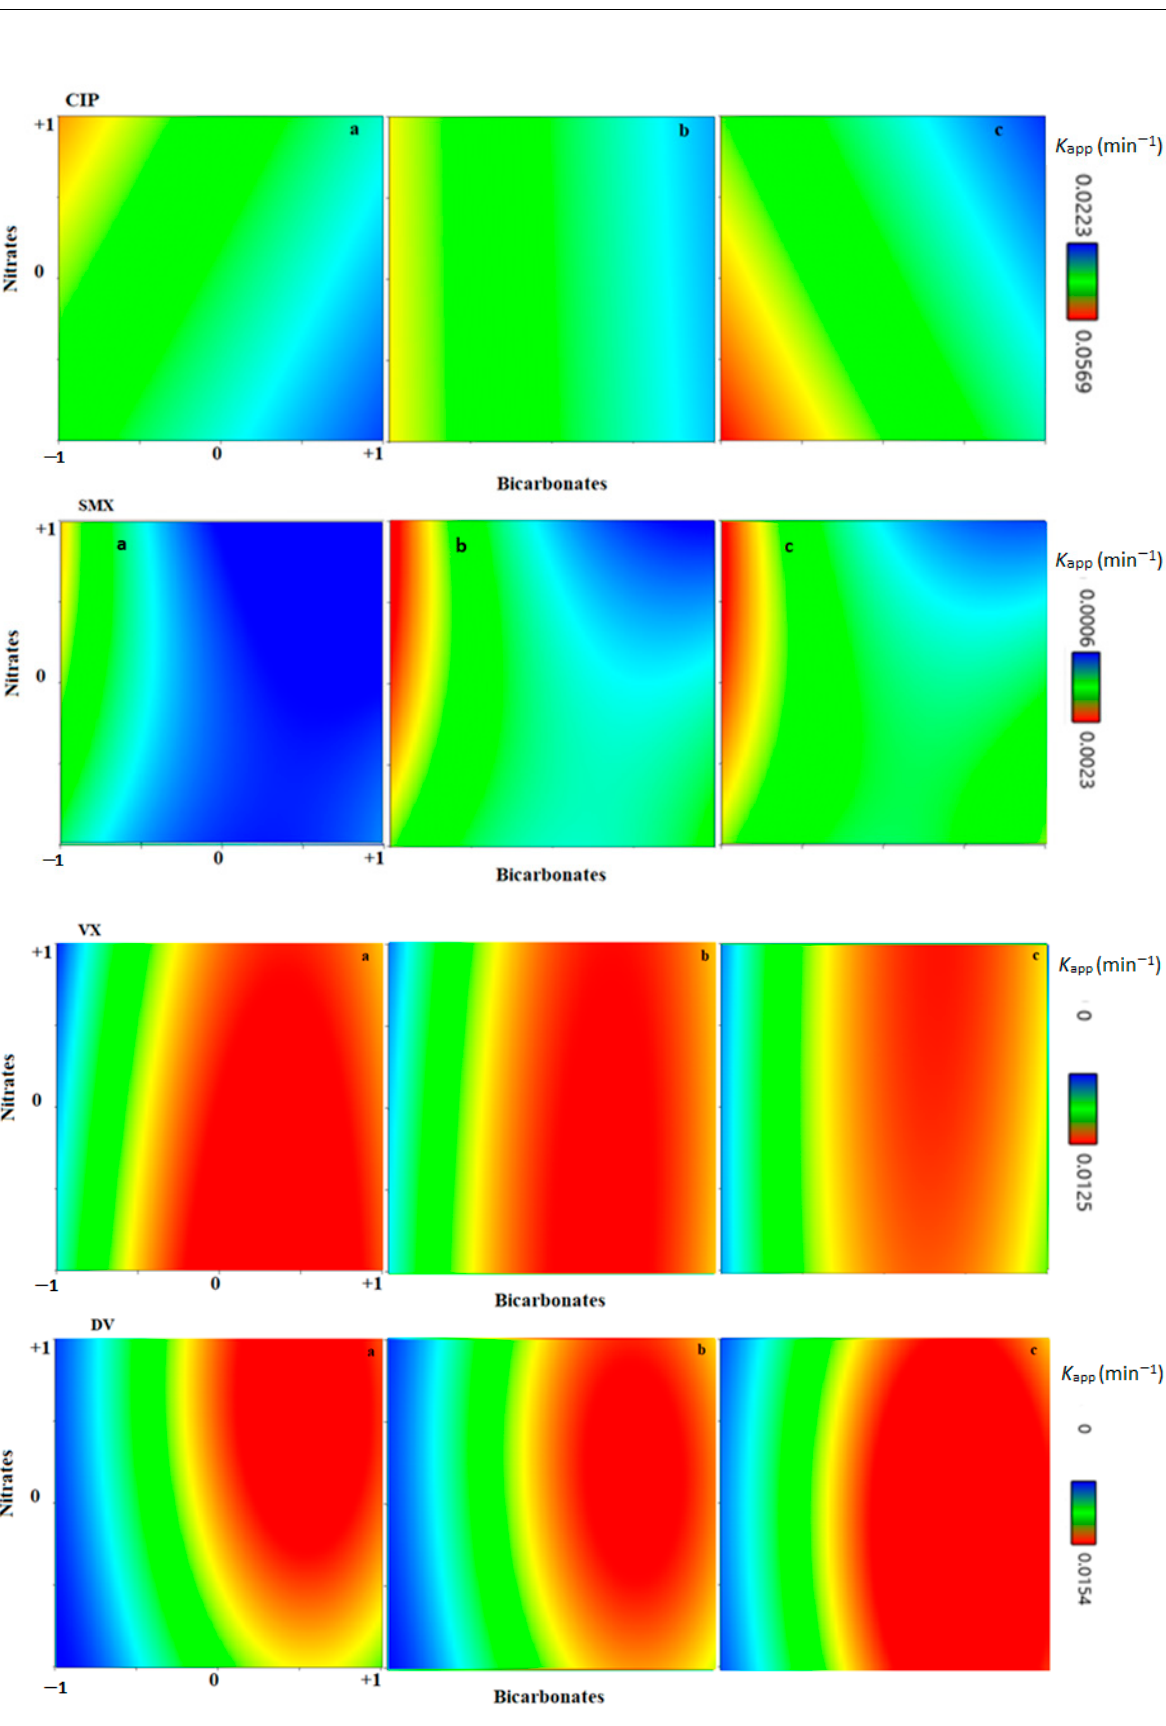
Figure 10. Surface graphs of k app for CIP, SMX, VX, and DV. X-axis: coded bicarbonates; Y-axis: coded nitrates; a, b, and c of each row represents humic acids coded values of − 1, 0, and +1, respectively.